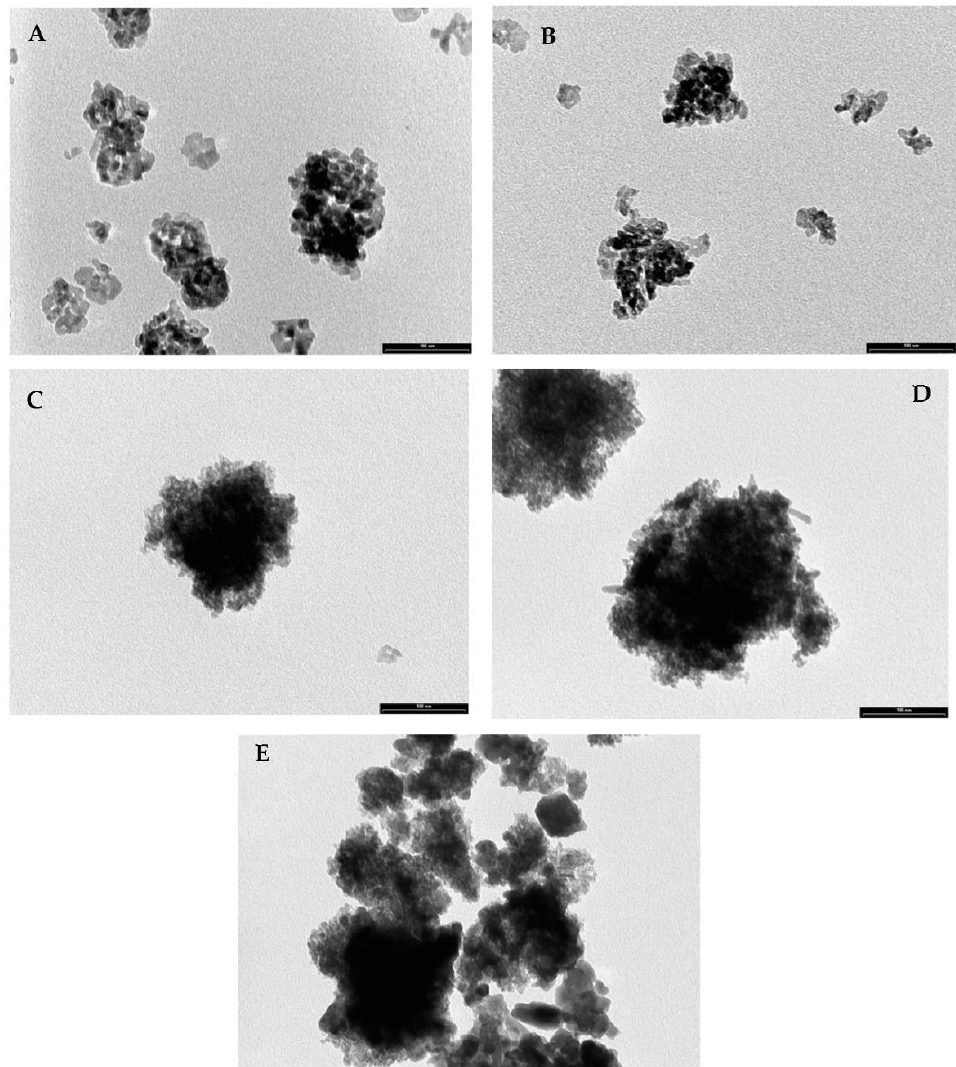
Figure 7. TEM images of WO 3 @TiO 2 _5 ( A ), WO 3 @TiO 2 _10 ( B ), WO 3 @TiO 2 _20 ( C ), WO 3 @TiO 2 _50 ( D ), WO 3 @TiO 2 _80 ( E ).